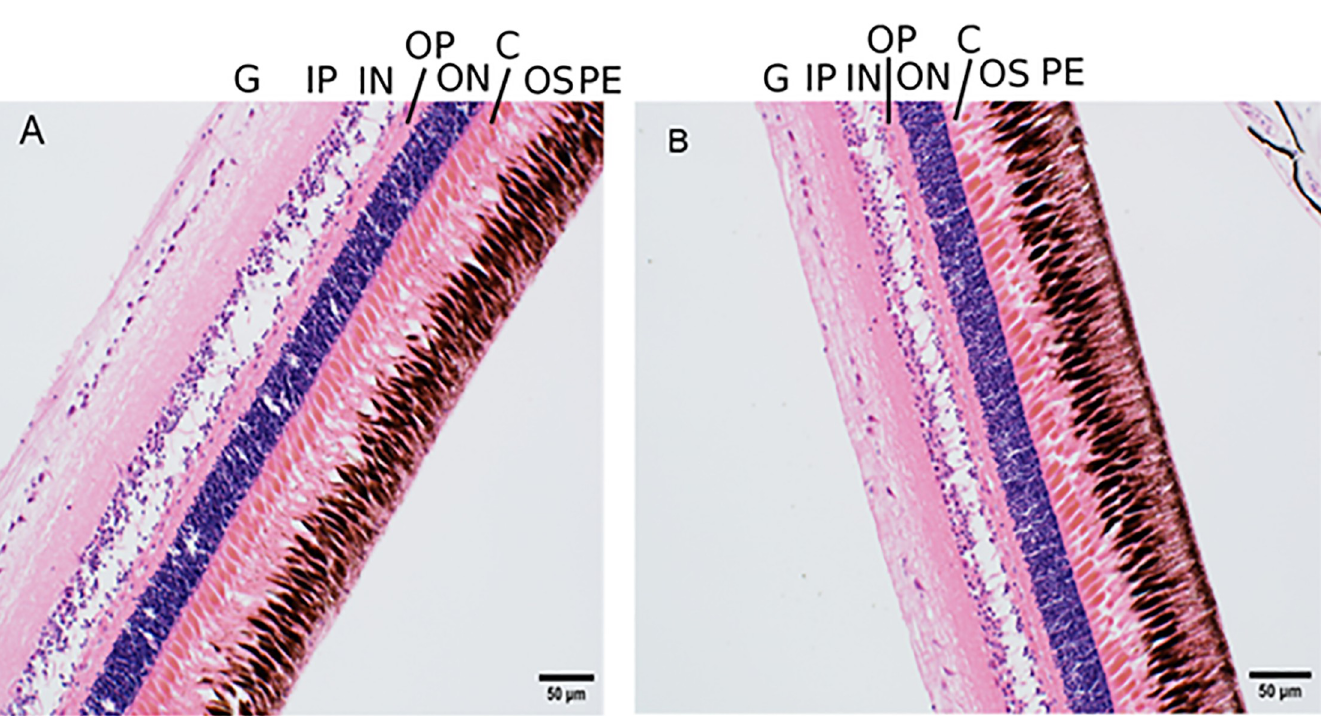
Fig 2. Identifiable layers in European sea bass retinas. Panels A and B are representative retina from fish fed a 0% and 5% taurine diet, respectively. G = ganglion cell layer, IP = inner plexiform layer, IN = inner nuclear layer, OP = outer plexiform layer; ON = outer nuclear layer, C = cone photoreceptors, OS = outer segments of the photoreceptor layer, PE = pigmented